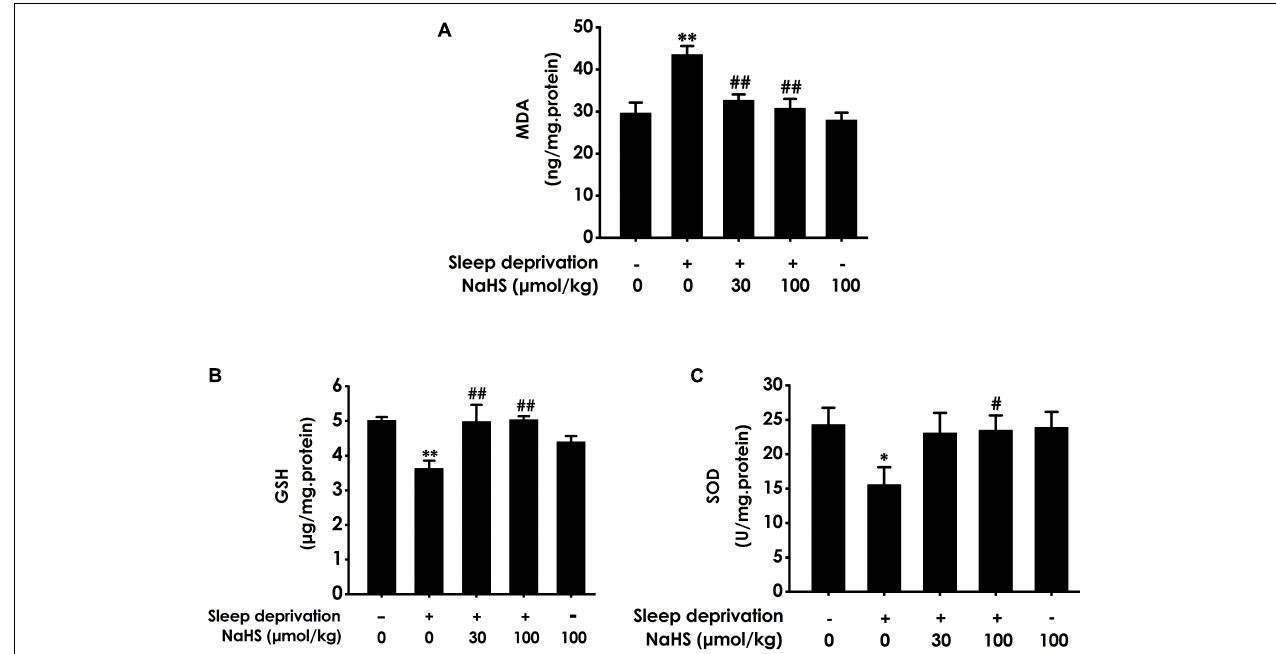
FIGURE 1 | Effect of hydrogen sulfide on sleep deprivation-exerted hippocampal oxidative stress in rats. Rats were pretreated with NaHS (30 and 100 µ mol/kg/d, ip) for 7 days and then cotreated with SD for 72 h. The level of MDA (A) and the content of GSH (B) in hippocampus were detected by ELISA kit. The activity of SOD (C) was measured by the NBT assay kit. Values are the means ± SEM ( n = 3). ∗ P < 0.05, ∗∗ P < 0.01, vs. control; # P < 0.05, ## P < 0.01, vs. SD-treated alone group.